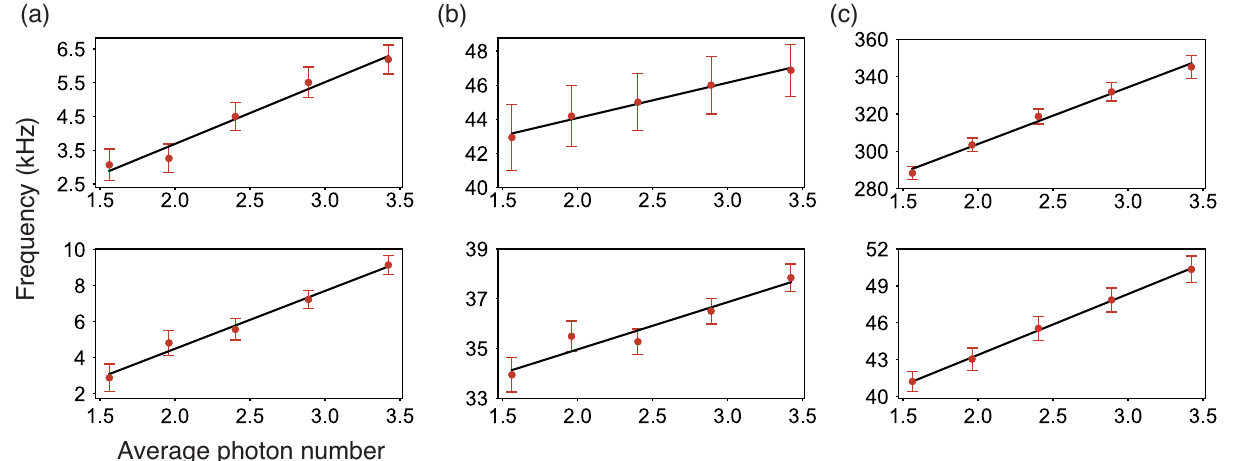
FIG. 5. Estimation of intrinsic and pump-induced self-Kerr. In all plots, the y coordinate corresponds to the effective frequency of a coherent state with average photon number ¯ n on the x coordinate. The slope determines the self-Kerr, and the offsets reflect pump- induced Stark shifts. Experiments for estimating the self-Kerr in the (a) absence of pumps, (b) presence of off-resonant squeezing pumps, and (c) presence of off-resonant beam splitter pumps for cavity A (top panels) and B (bottom panels).